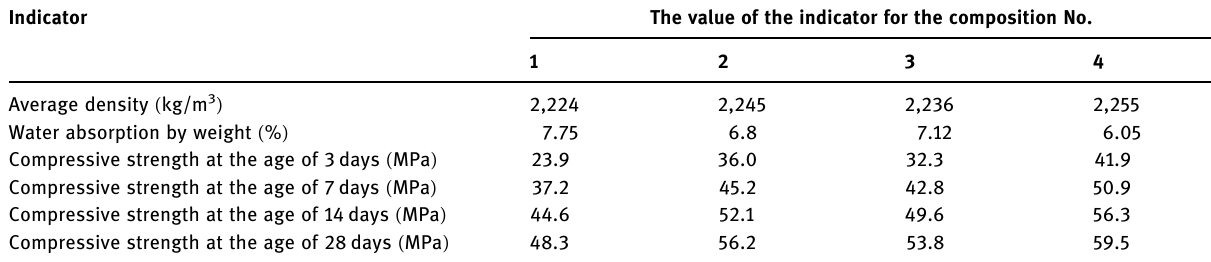
Table 10: Physical and mechanical properties of cement pastes Indicator The value of the indicator for the composition No.